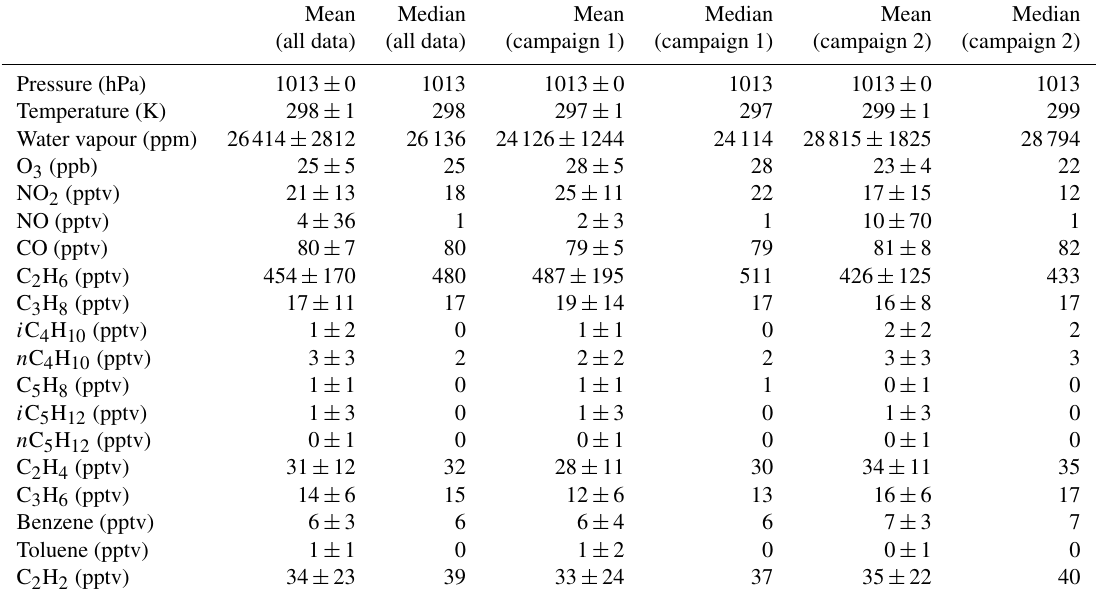
Table 1. Summary of supporting measurements at the Cape Verde Atmospheric Observatory during the ORC 3 campaign for periods during which glyoxal measurements were made. Zero values indicate measurements below the instrumental limit of detection. Chemical names are those used in the MCM. Details of measurement techniques, integration times, and uncertainties are given by Carpenter et al.